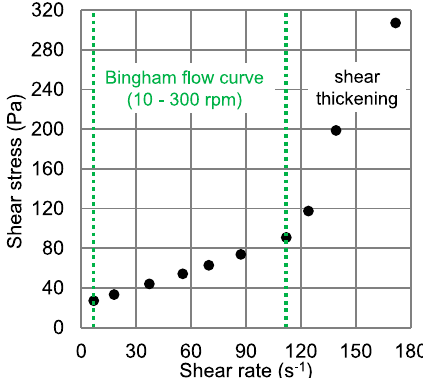
Figure 4. Typical results for torque as a function of rotational velocity, representative for all samples investigated with the Bingham approximation in the range of 10–300 rpm with regression coefficient (R 2 = 0.998).